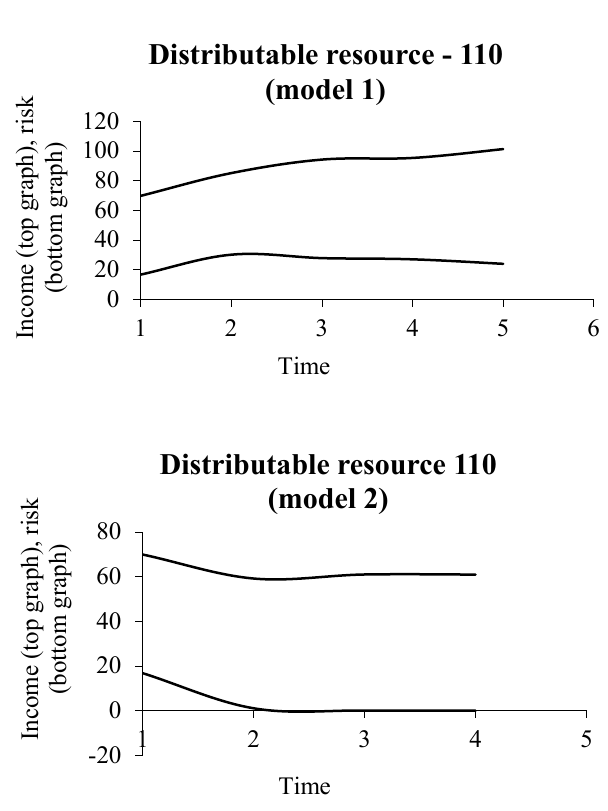
Figure 6. Dynamics of income and portfolio risk for model 1 ( above ) and model 2 ( below ) with an allocated resource of 110 units.